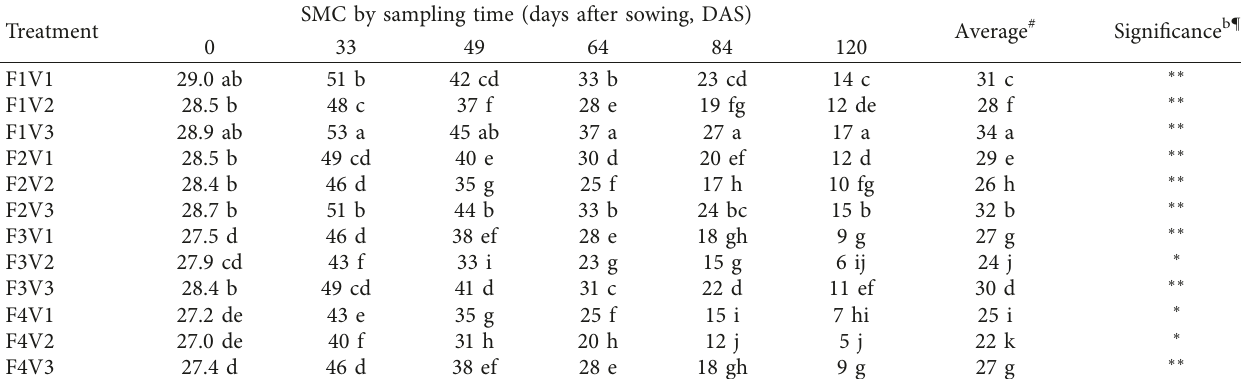
Table 6: Average soil moisture content (SMC) response to the combined effects of N +P fertilizer rates with tef crop varieties using the 2012 and 2013 cropping seasons in the Dura area, northern Ethiopia. SMC by sampling time (days after sowing, Treatment